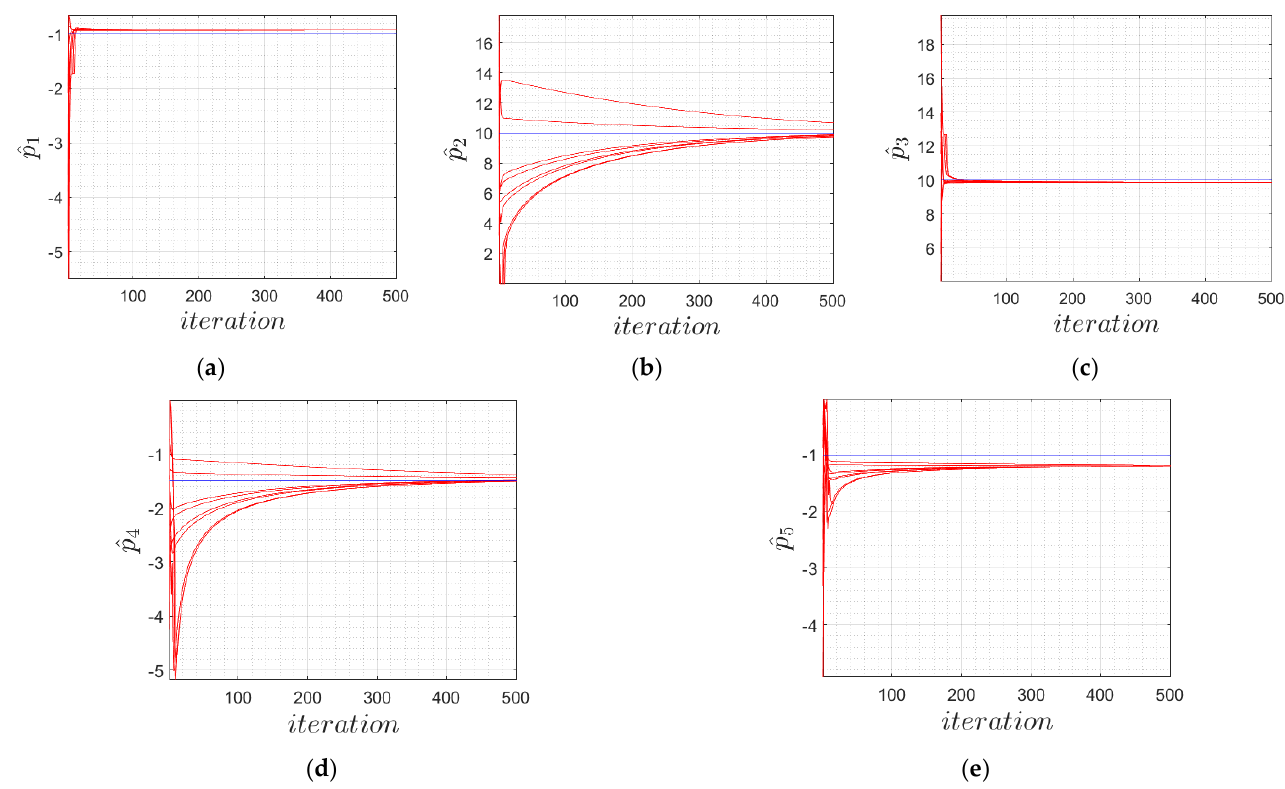
Figure 2. Convergence of the estimated parameters using EKF-based parameter estimation. ( a ) 𝑝̂ 1 convergence, ( b ) 𝑝̂ 2 convergence, ( c ) 𝑝̂ 3 convergence, ( d ) 𝑝̂ 4 convergence, ( e ) 𝑝̂ 5 convergence.